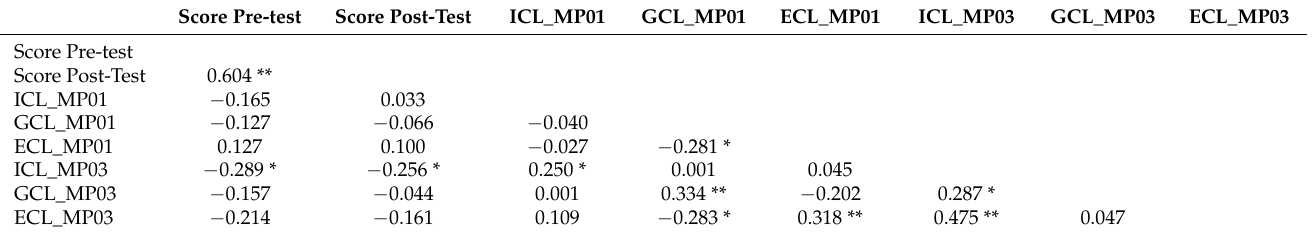
Table A1. Pearson correlations of domain-specific knowledge and cognitive load for the no-AR group.